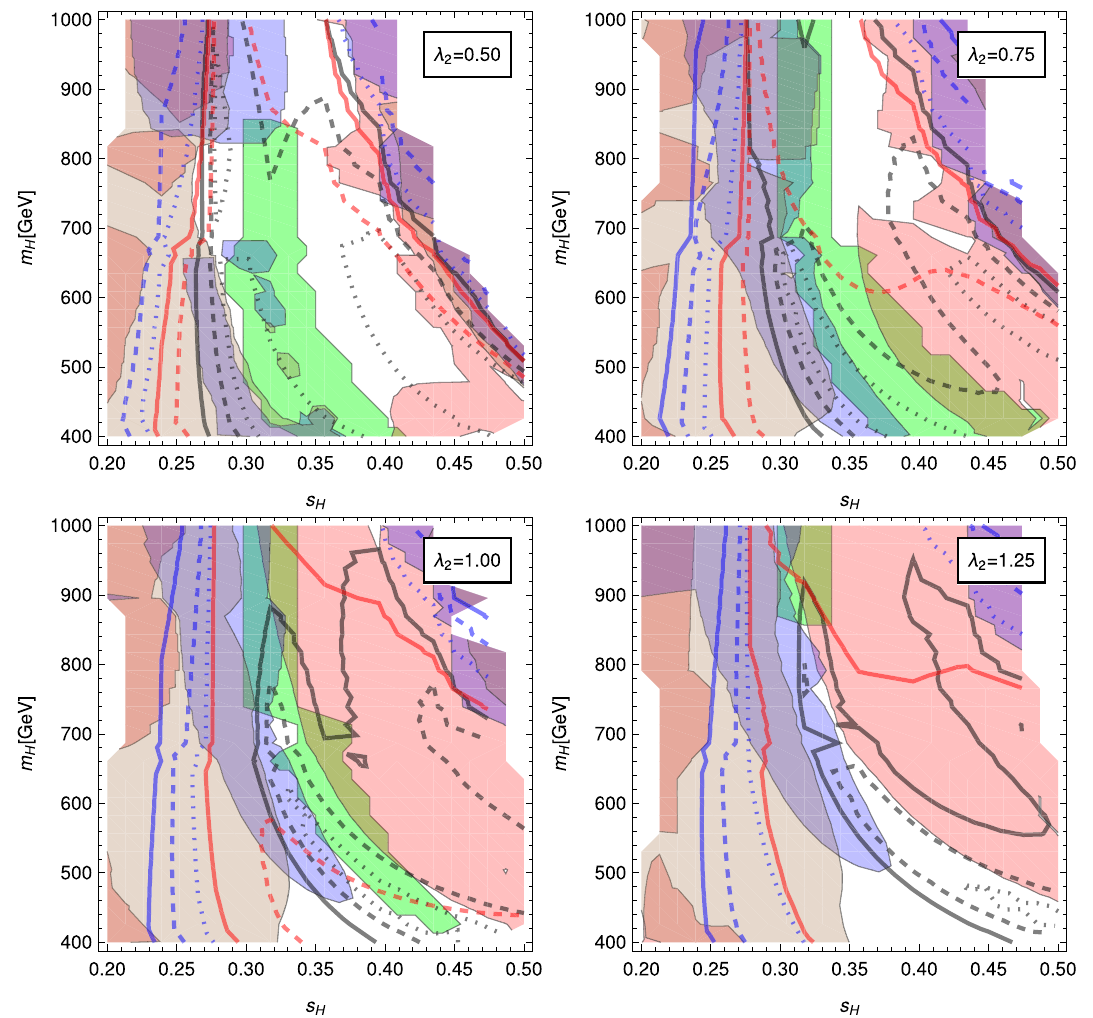
Fig. 9 Impact of the perturbativity constraints in the ( m H , s H ) plane Max ( | δλ x | ) = c π [dotted: c = 1; dashed: c = 2; full c = 4]. The black for different values of λ 2 on regions which are allowed at tree-level lines indicate Max ( | δλ x /λ x | ) > v [dotted: v = 1; dashed: v = 2; full: v = 4]. The red lines show when the tree-level unitarity limits calcu- (green areas). The other parameters are set to λ 3 = 0 . 5, λ 4 = − 0 . 1, λ = 0 . 1, α = 20 ◦ . The shaded area indicates the Higgs mass con- lated with ˜ λ ’s are violated when setting an upper limit on the scattering 5 ) 2 ) − ( m 2 ) | > | ( m 2 ) − ( m 2 ) | ) [red: h eigenvalues of 4 π (dotted), 8 π (dashed) or 16 π straints ( | ( m h Tree 1L 2L 1L 1 ; blue: h i h i h i i h 2 ; brown: h 3 ]. The blue lines are the contours of constant values for